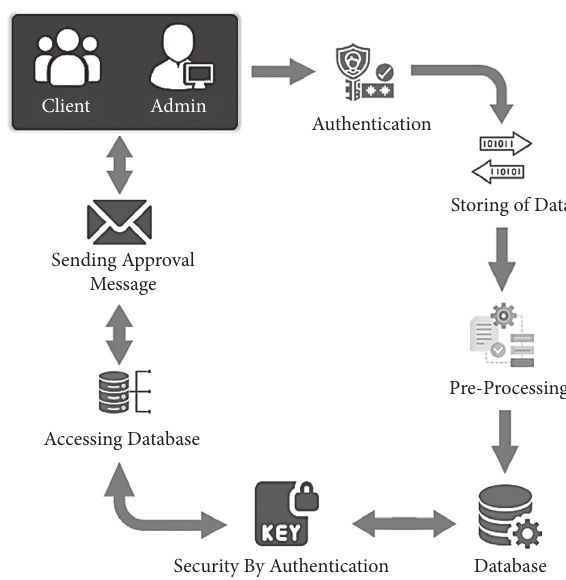
Figure 8: Flow chart of the proposed